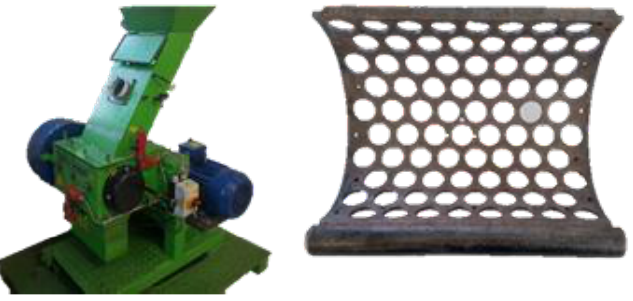
Figure 4. Universal granulator UG 300 ( left ), and outlet grate ( right ). With the sieve fraction of >1 mm, separator foils and cell housings were separated in a multi-stage sifting process using a zig-zag air-classifier. The remaining intermediate